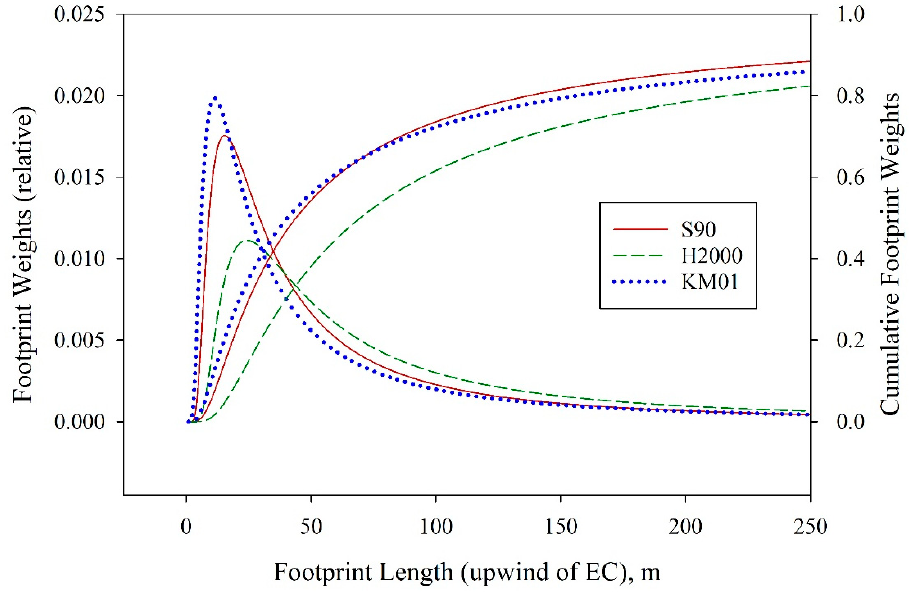
Figure 7. One dimensional plot of footprints at EC1 using the S90, H2000, and KM01 models during stable stratification on DOY 218 at 6:30 am CST.